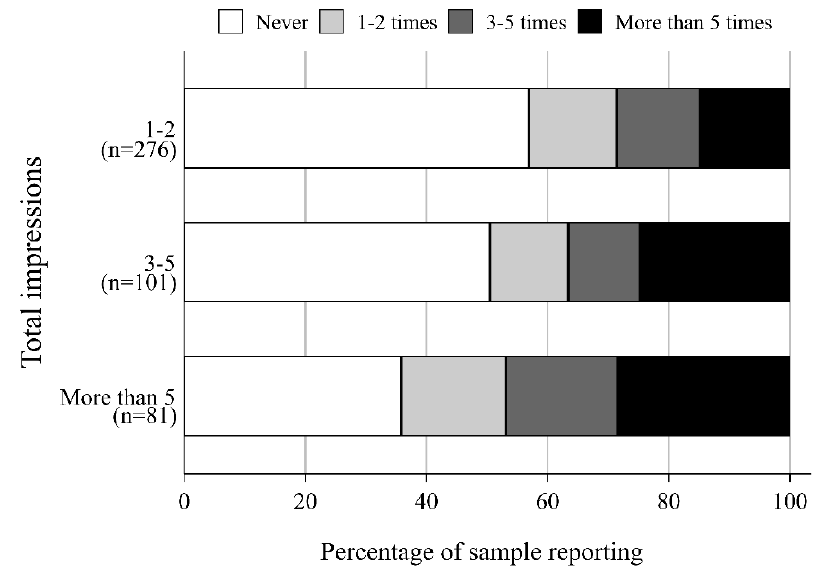
Figure 1. Observed self-reported frequency of exposure by the number of impressions delivered to participants in the Digital Exposure group ( n = 404).